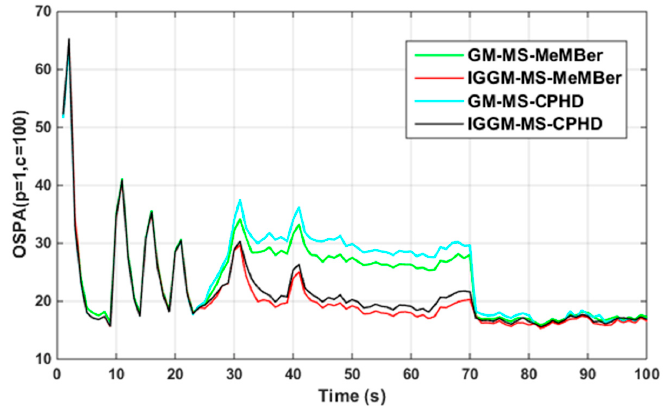
Figure 4. Optimal subpattern assignment (OSPA) distance.